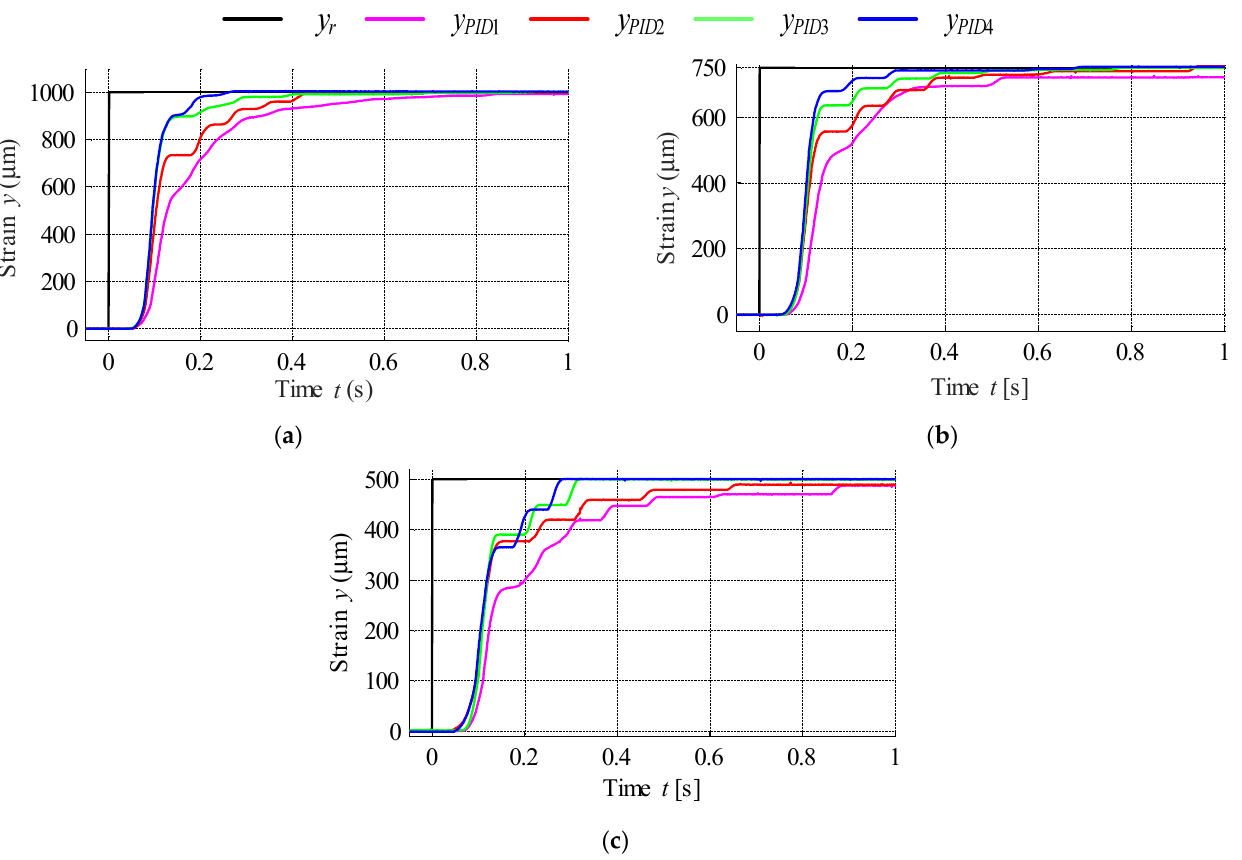
(25) Table 7. Integral absolute error.